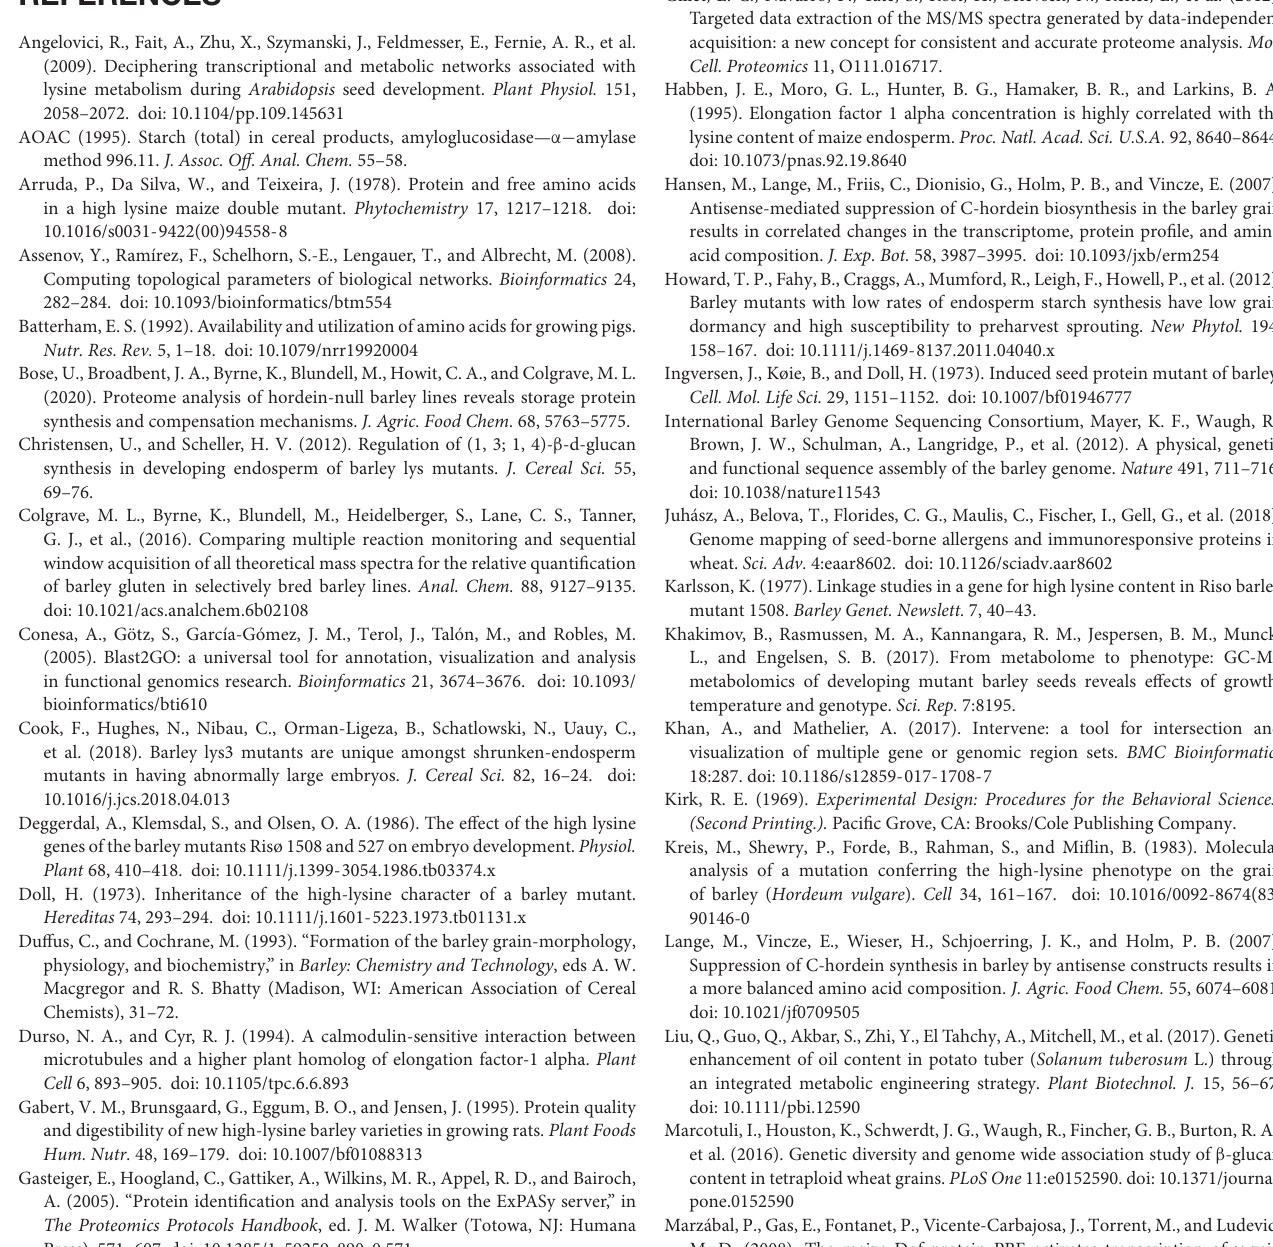
Supplementary Figure 4 | Enrichment of Prolamin box variants (TGTAAAGT,